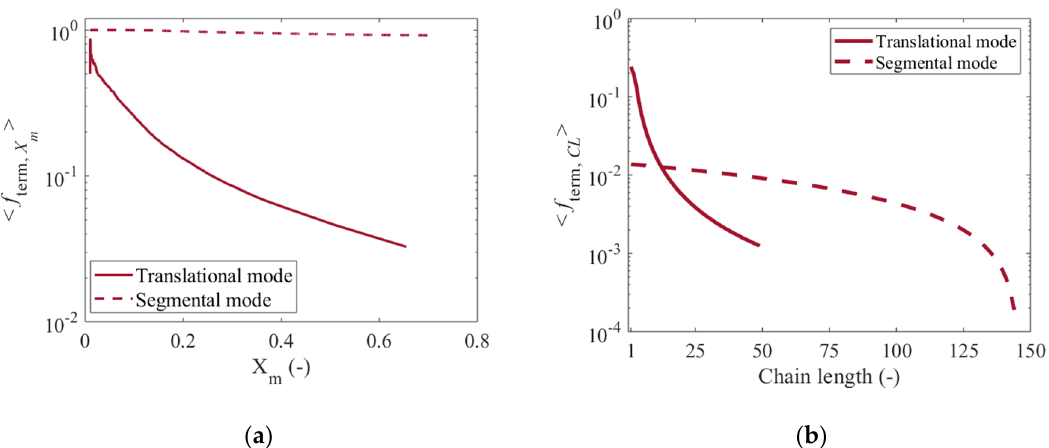
Figure 13. ( a ) Variation of the fraction of successful termination reaction events between surface and solution averaged for all the polymer chains < f > as a function of monomer conversion ( X m ). ( b ) term,X m Variation of the fraction of successful termination reaction events averaged for all X m (< f >) as a term,CL function of (free solution) chain length. In both cases, a comparison of the two termination